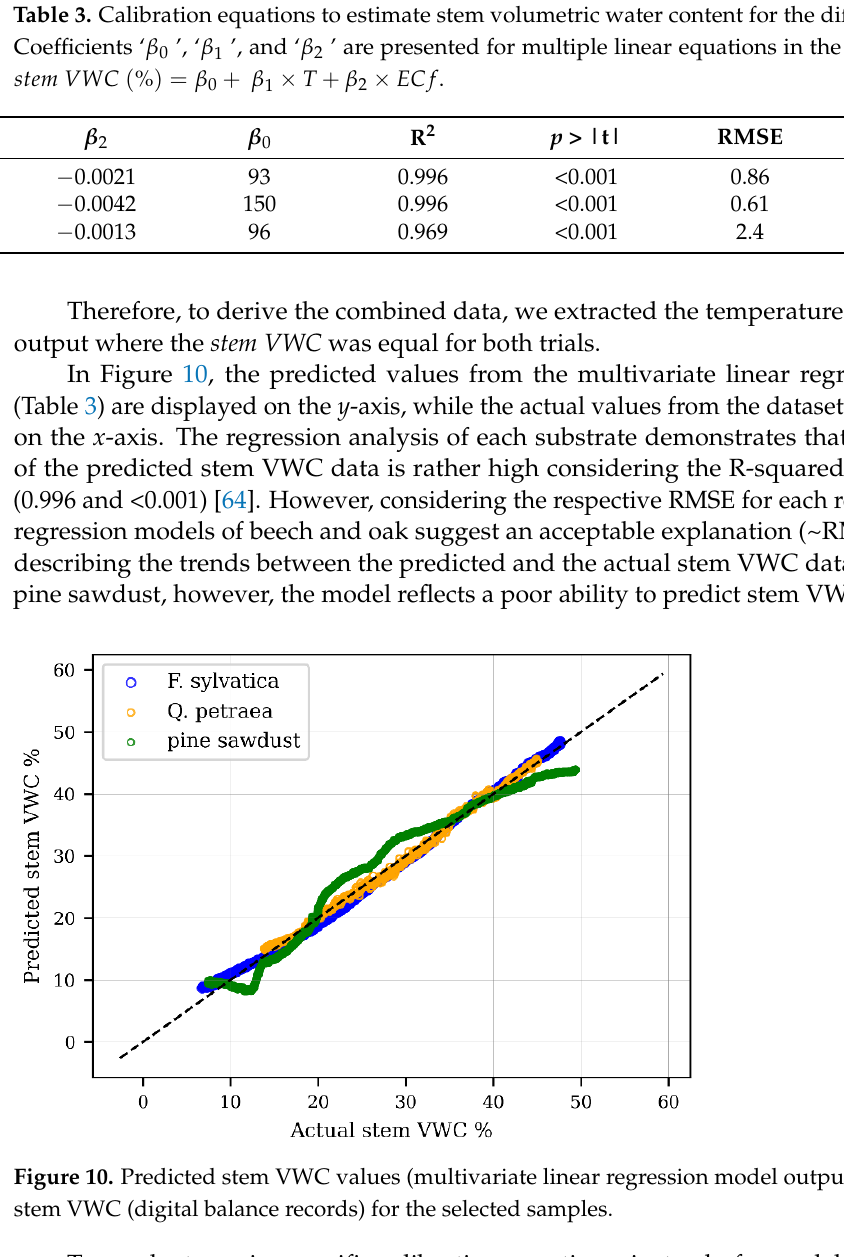
Table 3. Calibration equations to estimate stem volumetric water content for the different samples. Coefficients ‘ β 0 ’, ‘ β 1 ’, and ‘ β 2 ’ are presented for multiple linear equations in the standard form: